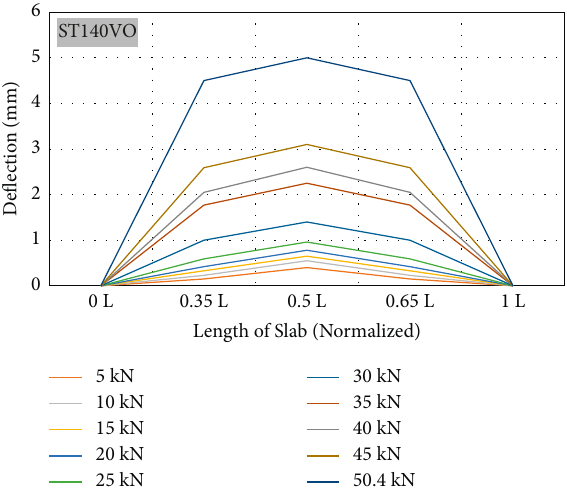
Figure 11: Deflection profile of slab ST140VO.